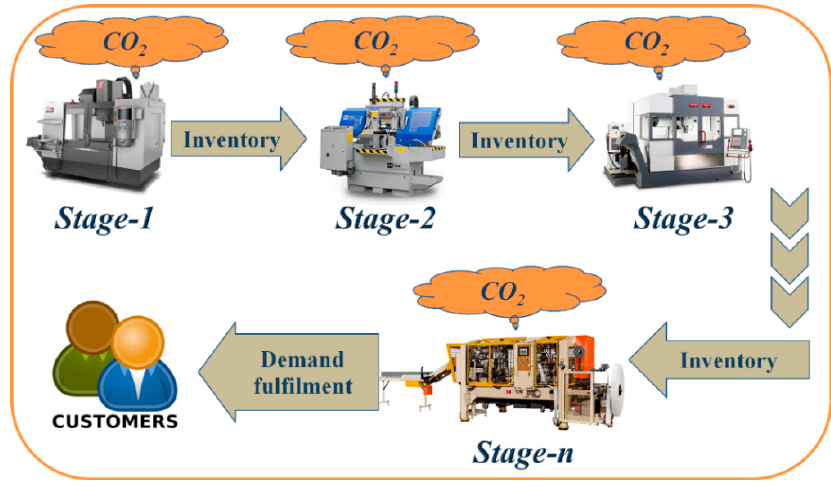
Figure 1. General flow of a multistage manufacturing process.